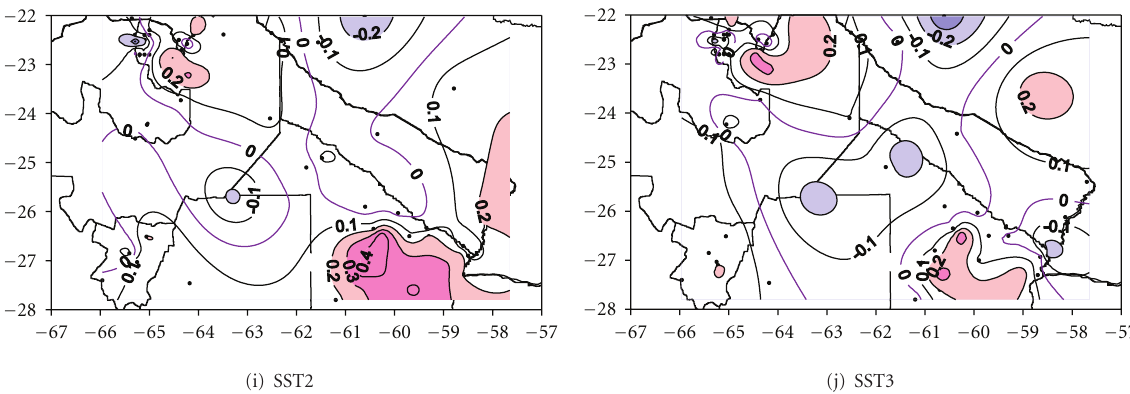
Figure 3: Correlation between summer (DJF) rainfall and indexes defined in the text. Areas shaded blue and red (light blue and pink) are significant at the 95% (90%) confidence level and represent negative (positive)